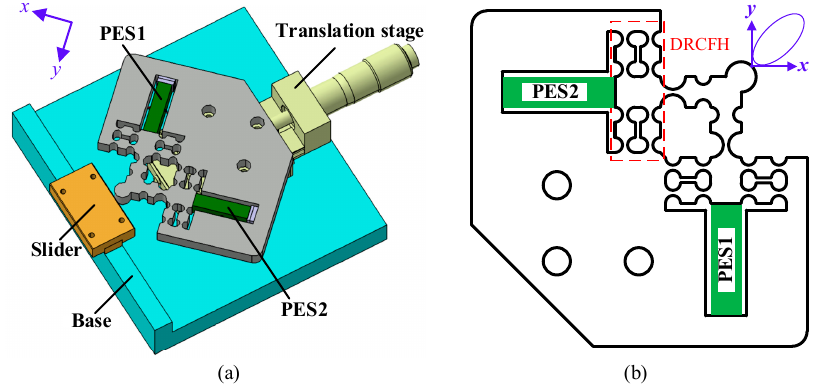
Figure 3. ( a ) Three-dimensional (3D) structure of the designed piezoelectric actuator working by employing the elliptical trajectory, and ( b ) structure of the flexure hinge mechanism for generating the elliptical